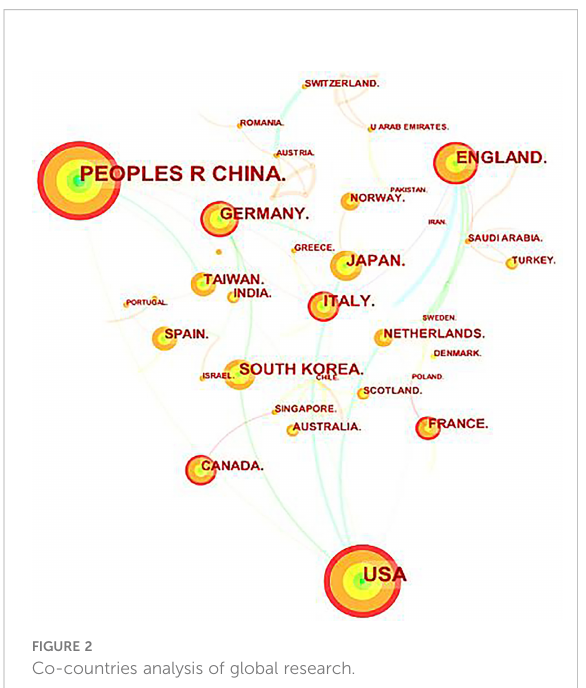
FIGURE 2 Co-countries analysis of global